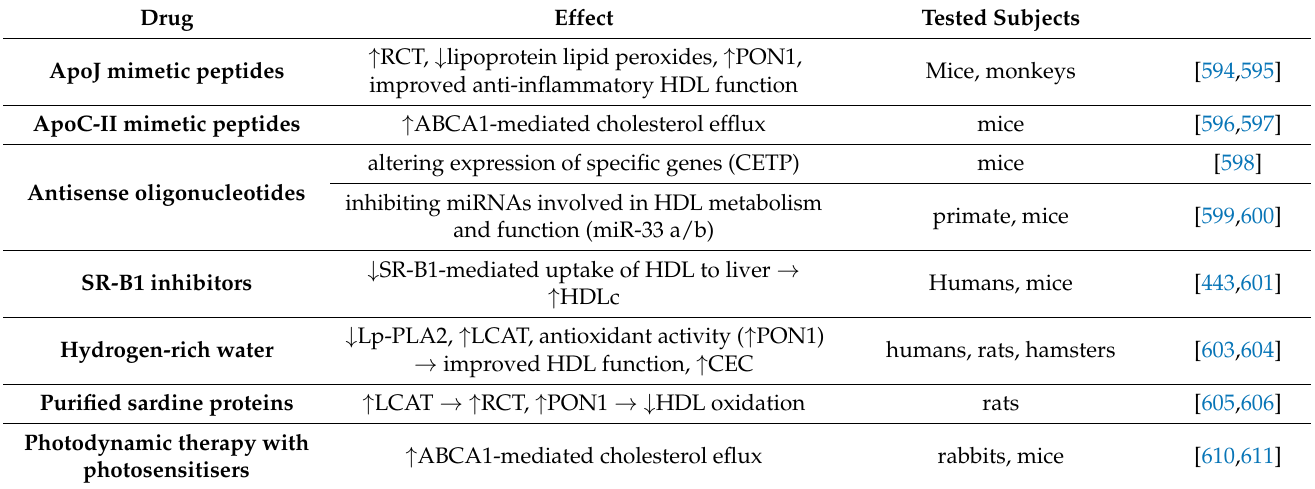
Table 5. Characteristics of experimental drugs affecting